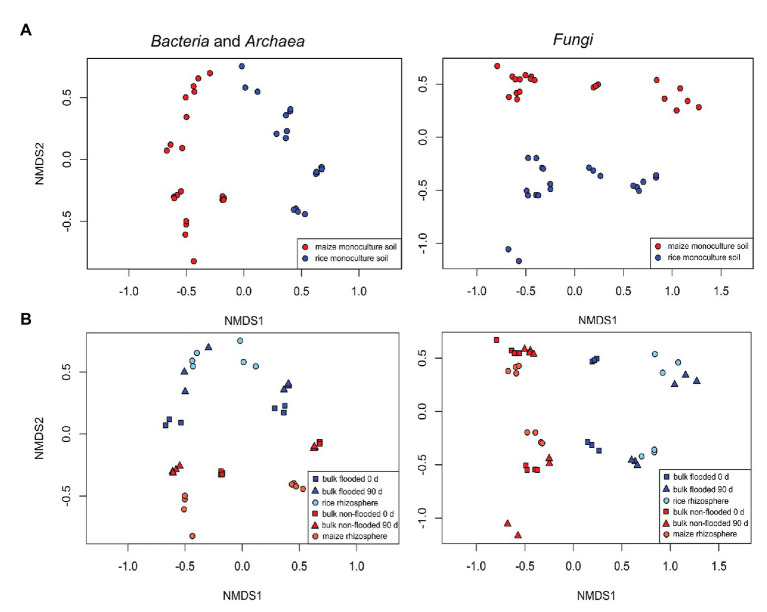
Non-metric multidimensional scaling (NMDS) plots showing differences in bacterial (left) and fungal (right) community composition due to (A) cropping history (upper panels) or (B) management/cultivated plant (lower panels, blue vs. red color). Additionally, compartment (light and dark color and symbol shape) and incubation period (symbol shape) are encoded in the lower panels. Flooded bulk soil was taken at day 0 was flooded 24 h before sampling.